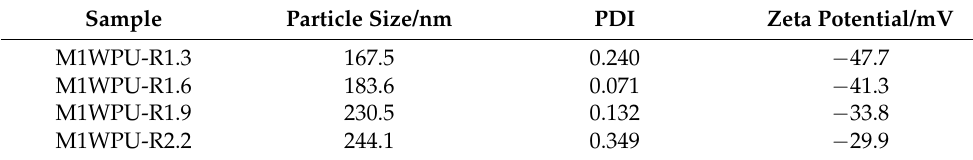
Table 3. The results of the particle size and zeta potential for different R values.